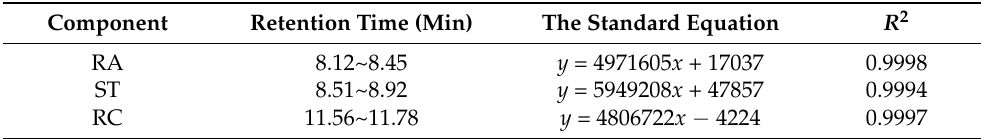
Table 1. Retention time and standard curve equations of three